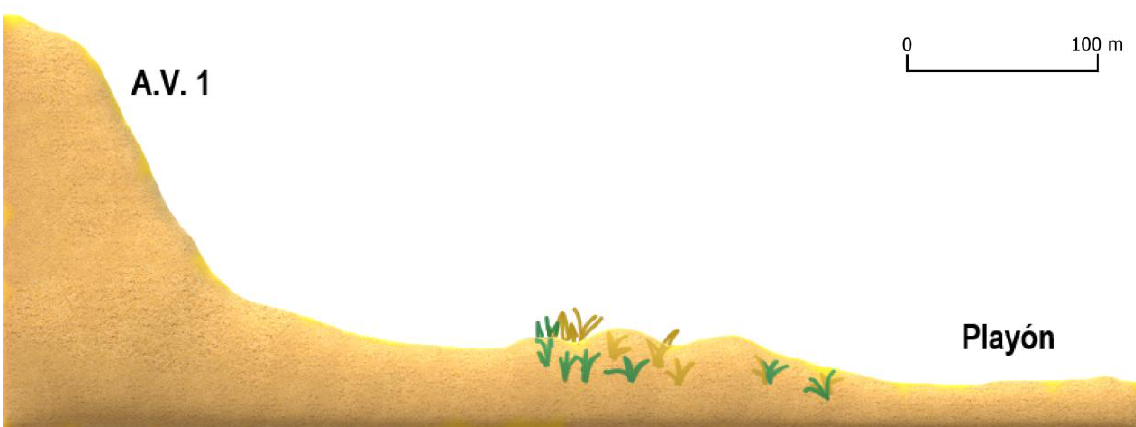
Figure 6. Diagram of Arroyo Verde locality and the spatial relationship between the Arroyo Verde 1 (Gómez Otero 2006) and Playón locus